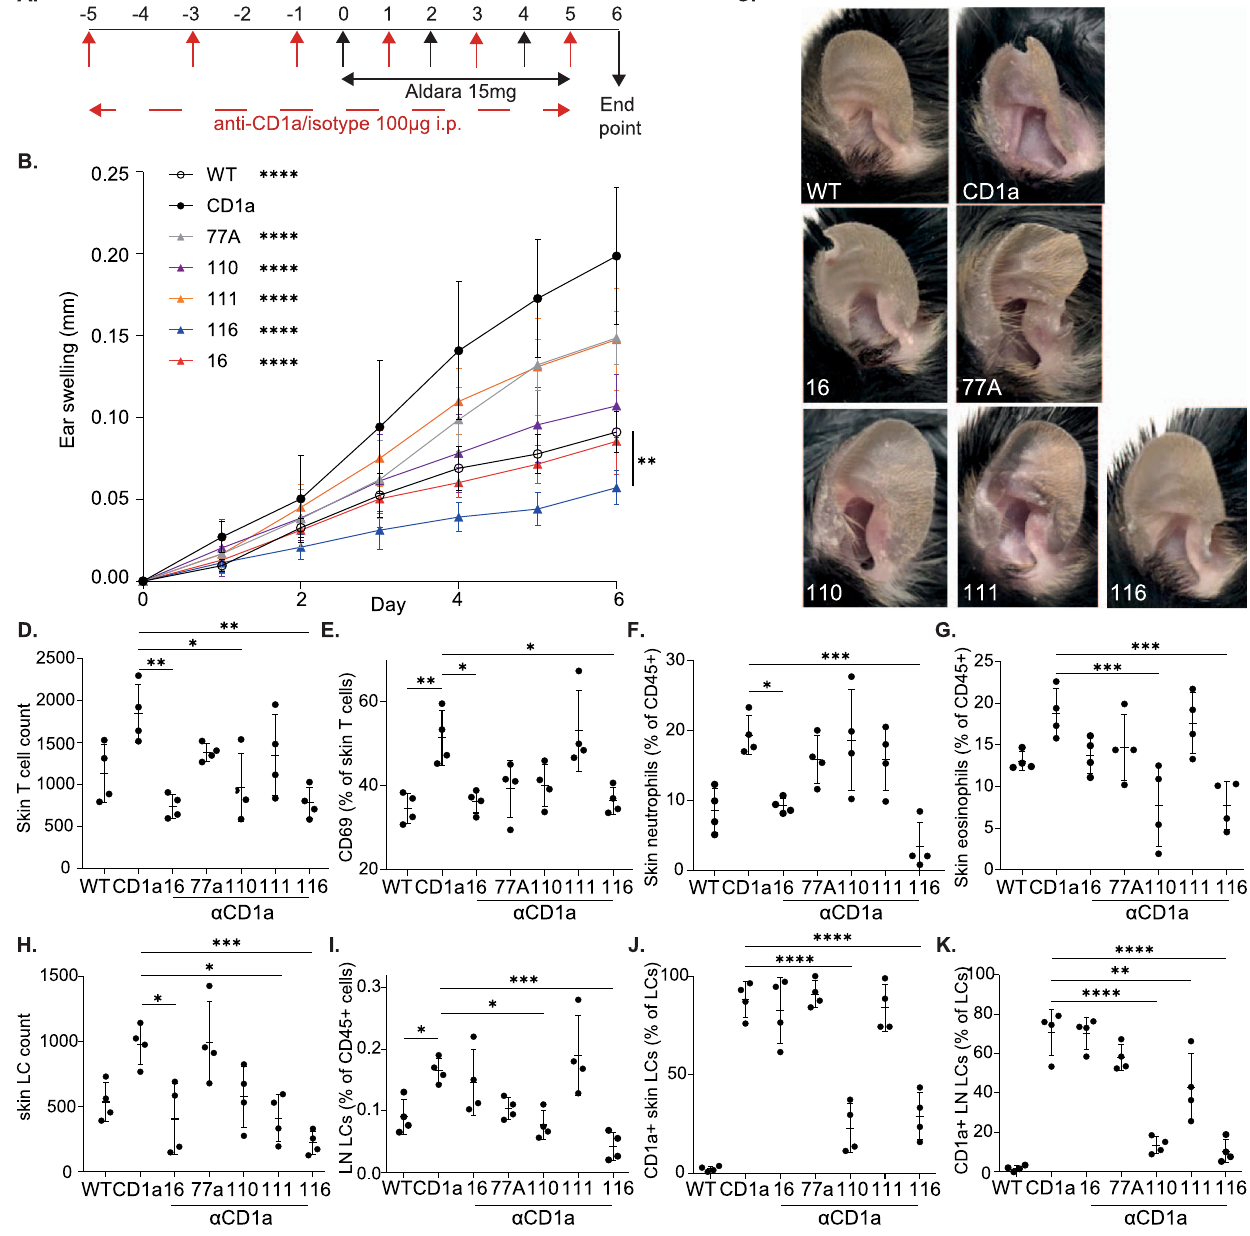
Fig. 4 | Characterization of anti-CD1a antibodies in vivo. A Schematic of imiquimod-induced skin in fl ammation and anti-CD1a preventative administration. B Dailymeasurementofearswellinginduced byimiquimodtreatmentof wild-type (WT)andCD1atransgenicmice(CD1a)injectedi.p.withmouseIgG1isotypecontrol and CD1a transgenic injected with the re fi ned panel of anti-CD1a antibodies as in the schematic panel A . Mean±SD is shown. n represents biologically independent animals in each group. B n =6 for all groups examined over 3 independent experiments.Two-way-ANOVAwithTukey ’ stest,** P <0.01;**** P <0.0001indicates signi fi cance at day 6 on comparison to “ CD1a ” or as shown. C Representative imagesofin fl ammationonday6oftheimiquimodtreatmentofwild-type(WT)and CD1atransgenicmice(CD1a)injectedi.p.withmouseIgG1isotypecontrolandCD1a transgenic injected with the re fi ned panel of anti-CD1a antibodies as in the